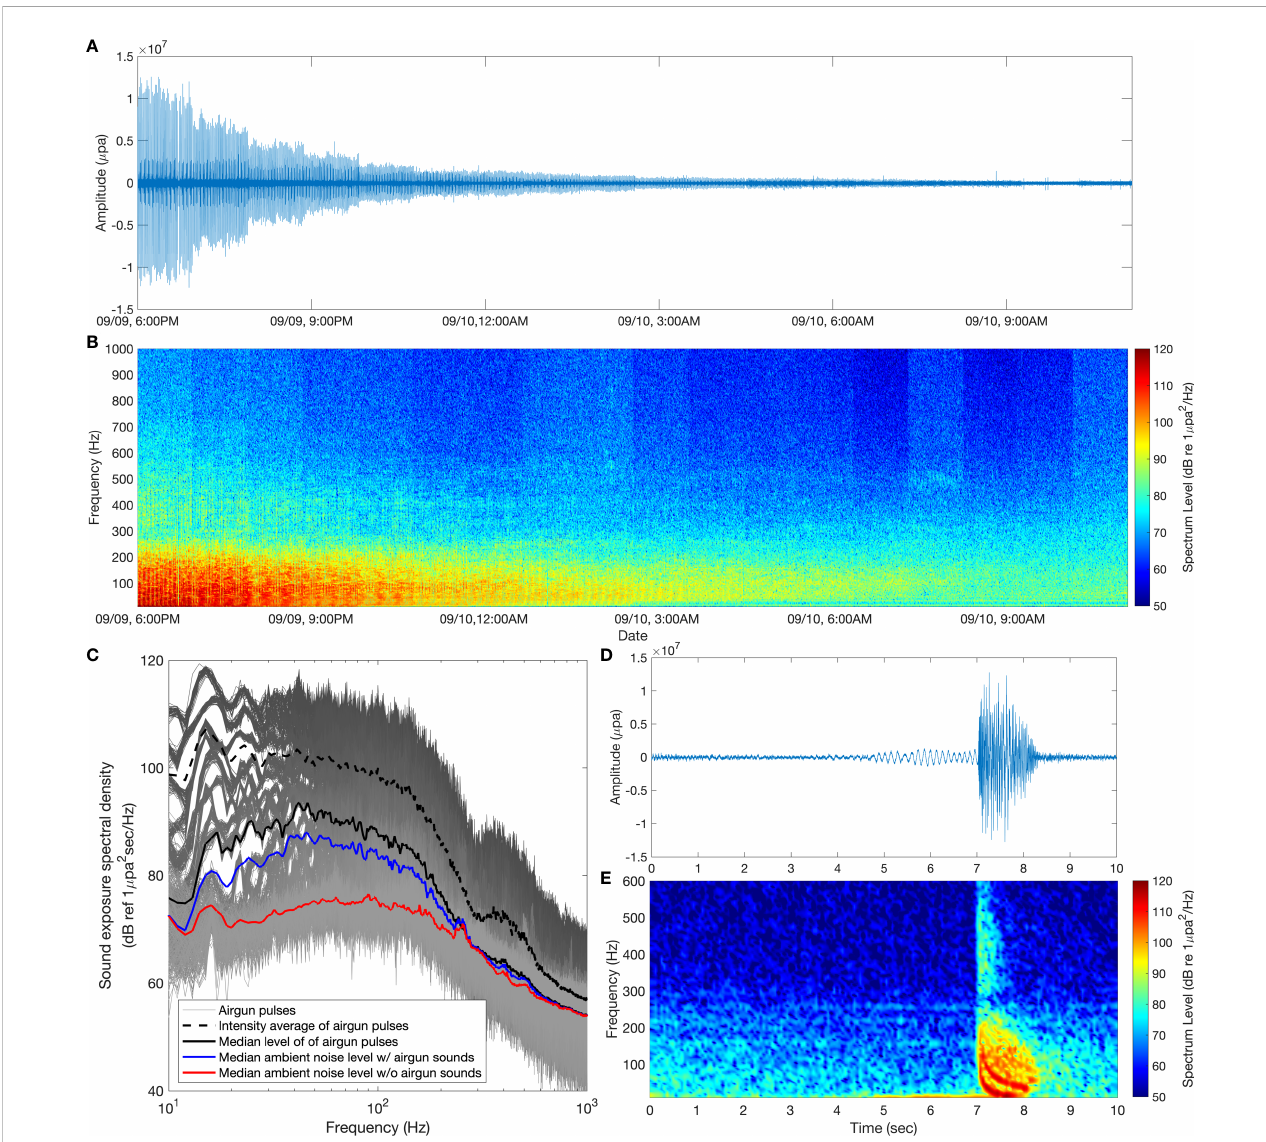
FIGURE 4 (A) Waveform and (B) spectrogram from 18:00 on 9 September to 11:10 on 10 September. Both are expressed by recorded acoustic data in a series of a 10-min recording and 50-min break schedule. (C) The sound exposure spectral densities of 979 pulses measured from short to long distances are expressed as dark- to light-gray thin lines. The intensity average and median spectrum levels are expressed as dashed and solid black lines, respectively. Median spectrum levels estimated from full acoustic data with and without airgun sound are represented by blue and red solid lines. (D) and (E) show the waveform and spectrogram of a single airgun pulse measured at the beginning of recording (8,192 fast Fourier transform points and 4,096-point Hanning